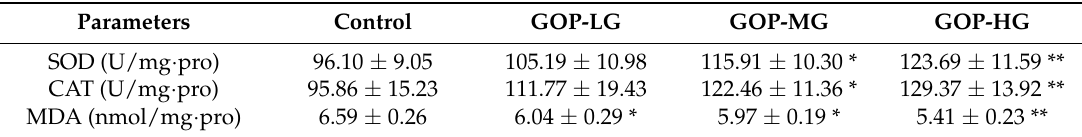
Table 4. Effects of GOP on SOD, CAT activity, and MDA levels in skeletal muscles of mice. Parameters Control GOP-LG GOP-MG GOP-HG SOD (U/mg · pro)